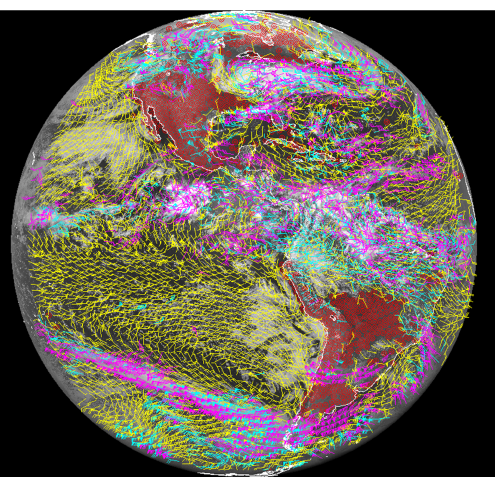
Figure 3. Three-Satellite Stereo Winds across the Full Disk of GOES-18 (Band 2, 18:00Z on 6 May 2022). The wind barbs are color coded to indicate retrieved geometric height (0–3000 m, yellow, 3000–7000 m, cyan, 7000–16,000 m, magenta). The wind barbs have been thinned to remove over- lapping values and calm winds (ground points) are plotted in red. There are 380,179 high-quality retrievals in this dataset before thinning. Ground point retrieved heights can be compared with a digital terrain model to provide an indication of the accuracies of the retrieved geometric heights. Note: GOES-18 Preliminary, Non-Operational Data.